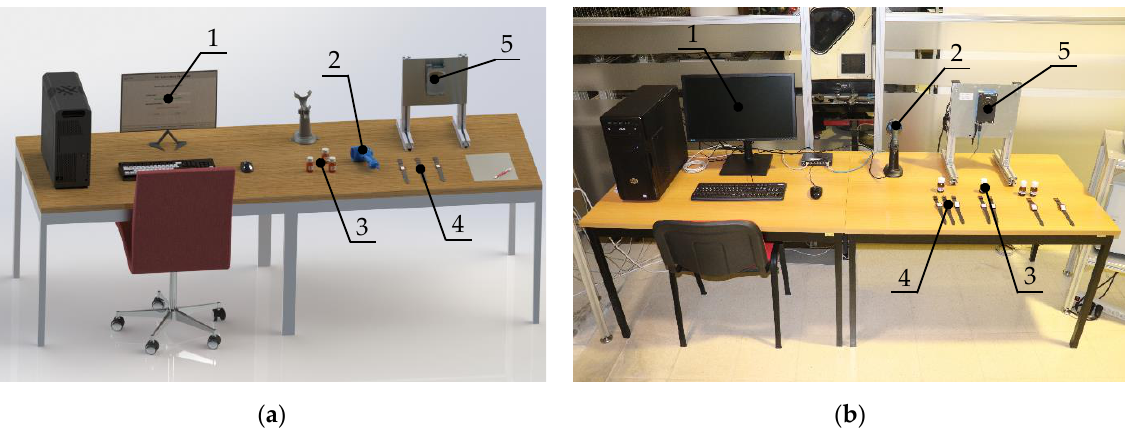
Figure 5. PLC Platform components: ( a ) Prototype; ( b ) Implementation.